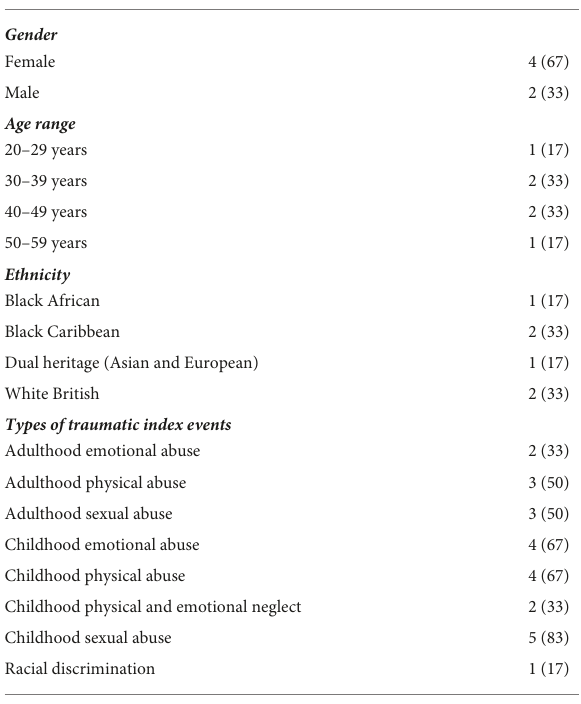
TABLE 3 Interview sample participant characteristics ( N =